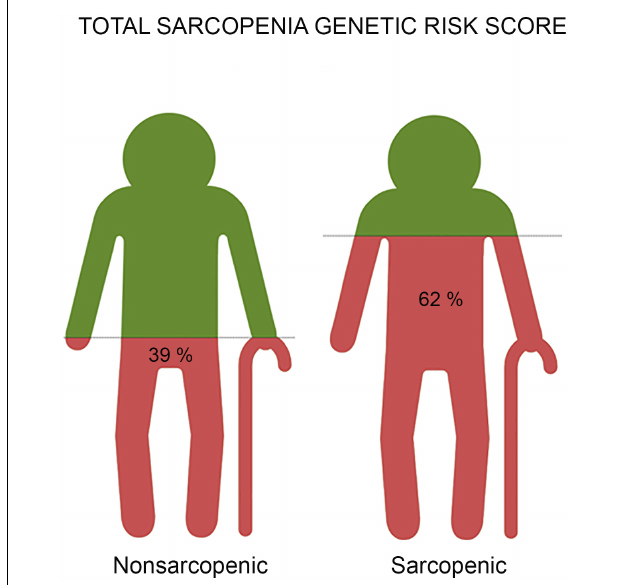
FIGURE 2 | The representative images reveal the result of risk prediction based on a total genetic risk score for sarcopenia with the combined effect of all three (MTHFR, ACTN3, and NRF2) gene polymorphisms associated with sarcopenia in older adults. Each image represents a group of participants - non-sarcopenic and sarcopenic. We found a significantly higher total genetic risk score in sarcopenic participants compared to controls (62% vs. 39%, p < 0.001). Older adults with a genetic risk score of ≥ 58.3% had 1.9 increased odds ratios for the likelihood of being sarcopenic compared to those with a lower total sarcopenia genetic risk